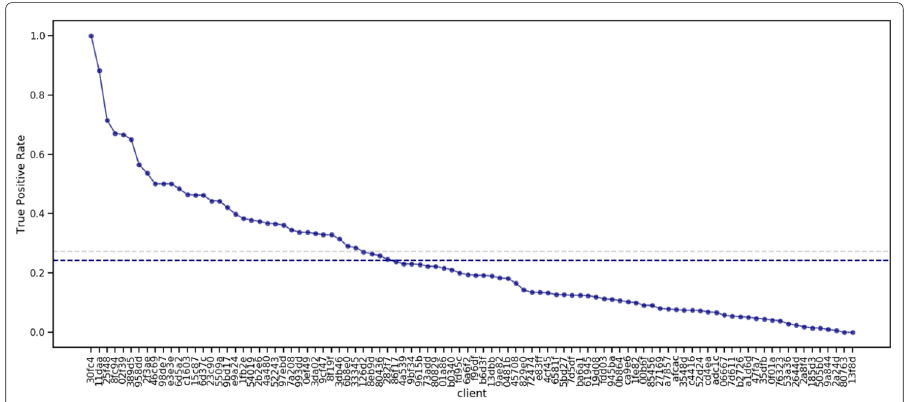
Fig. 17 True Positive Rate for each client in the Audit Dataset. The True Positive Rate represents the number of fraudulent transactions correctly attributed by GraphSIF. The values on the x axis represent a client company from the Audit dataset. The grey dotted line represents the random baseline, while the blue dotted line represents the mean TPR over all